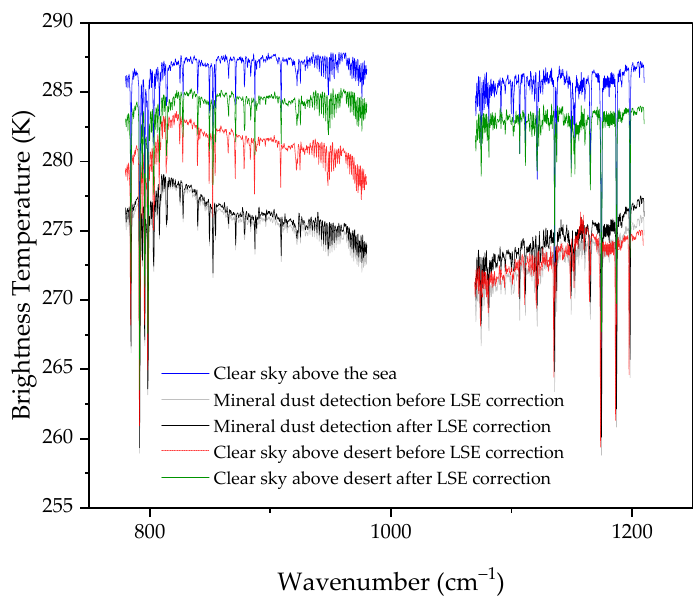
Figure 6. IASI spectral detection example for a clear sky above the sea compared to a clear sky above the desert and mineral dust detection before and after LSE optimization.